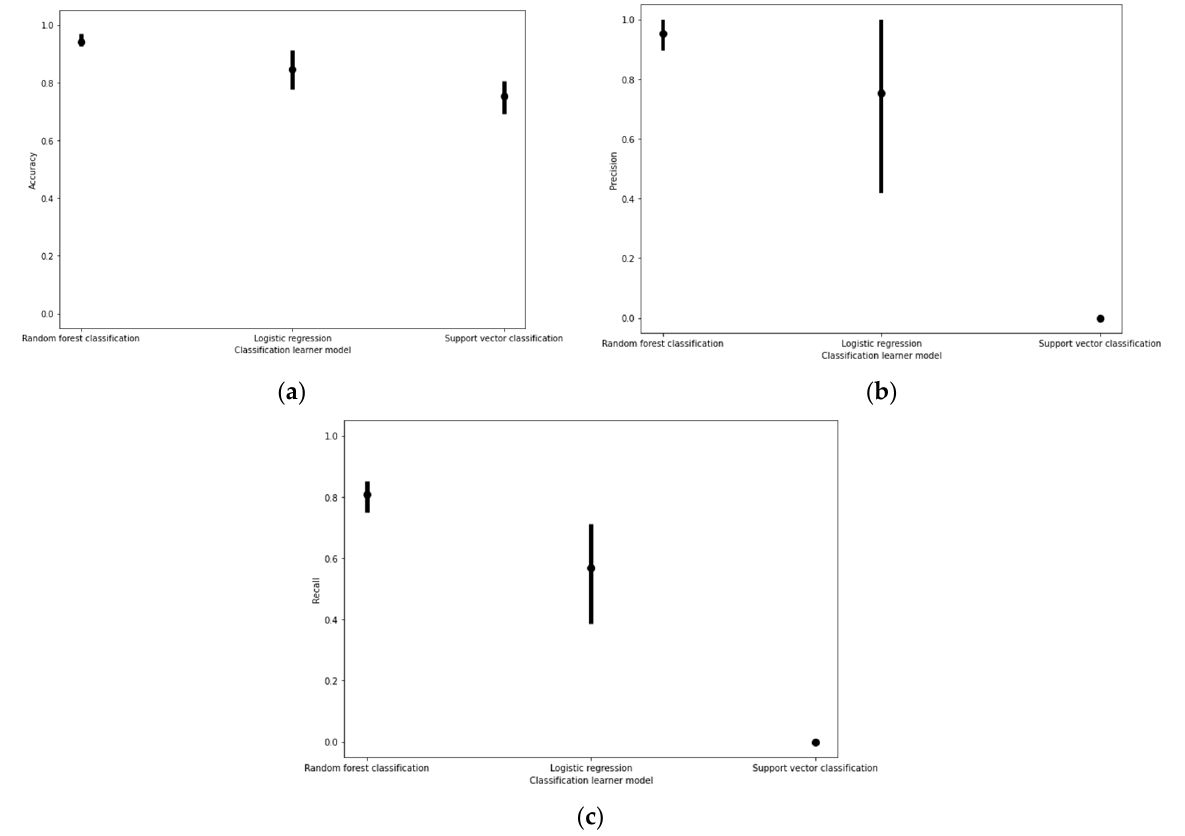
Figure 5. Filament diameter classification model performance based on ( a ) accuracy, ( b ) precision, and ( c ) recall scores under fivefold cross validation. The upper and lower bounds of the error plots represent the maximum and minimum scores produced amongst all five combinations of one fold being trained and tested on the remaining four folds.